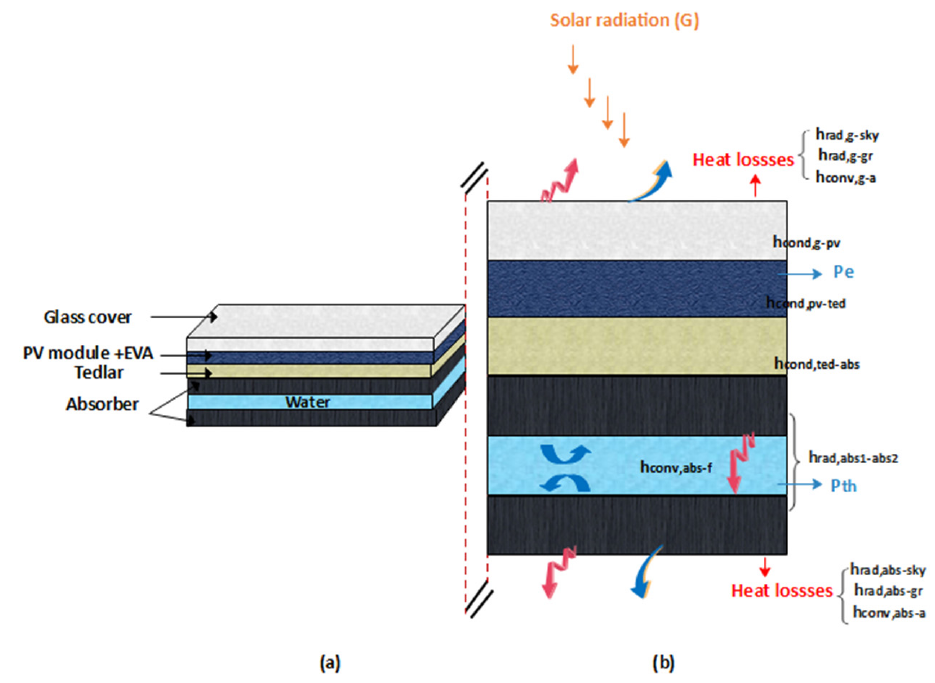
Figure 1. Components ( a ) and heat exchange mechanism in the PV/T system ( b ). The main PV technical characteristics (applied to Standard Test Conditions of solar Table 1. PV module technical characteristics applied to STC. irradiance of 1000 W/m 2 and ambient temperature of 25 ◦ C) and the selected PV/T sys- tem properties are reported in Tables 1 and 2. Moreover, the assumptions considered in developing the PV/T model due to its different components were [22,23,26]: